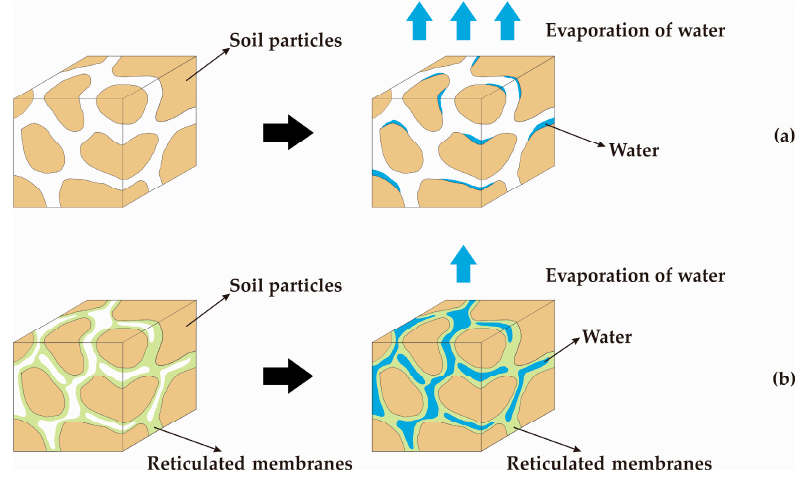
Figure 9. The schematic diagram of the moisture retention property: ( a ) soil; ( b ) soil reinforced by PVAc.